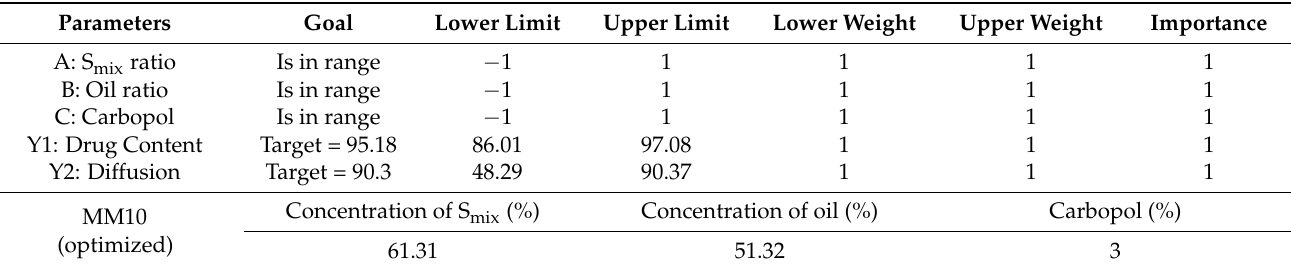
Table 4 . Criteria for numerical optimization.